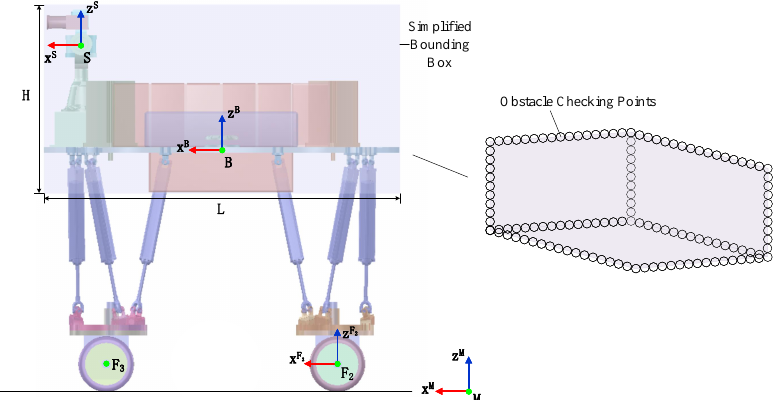
Figure 4. The robot model and obstacle checking points on abstract outline, which are regarded as a part of planner